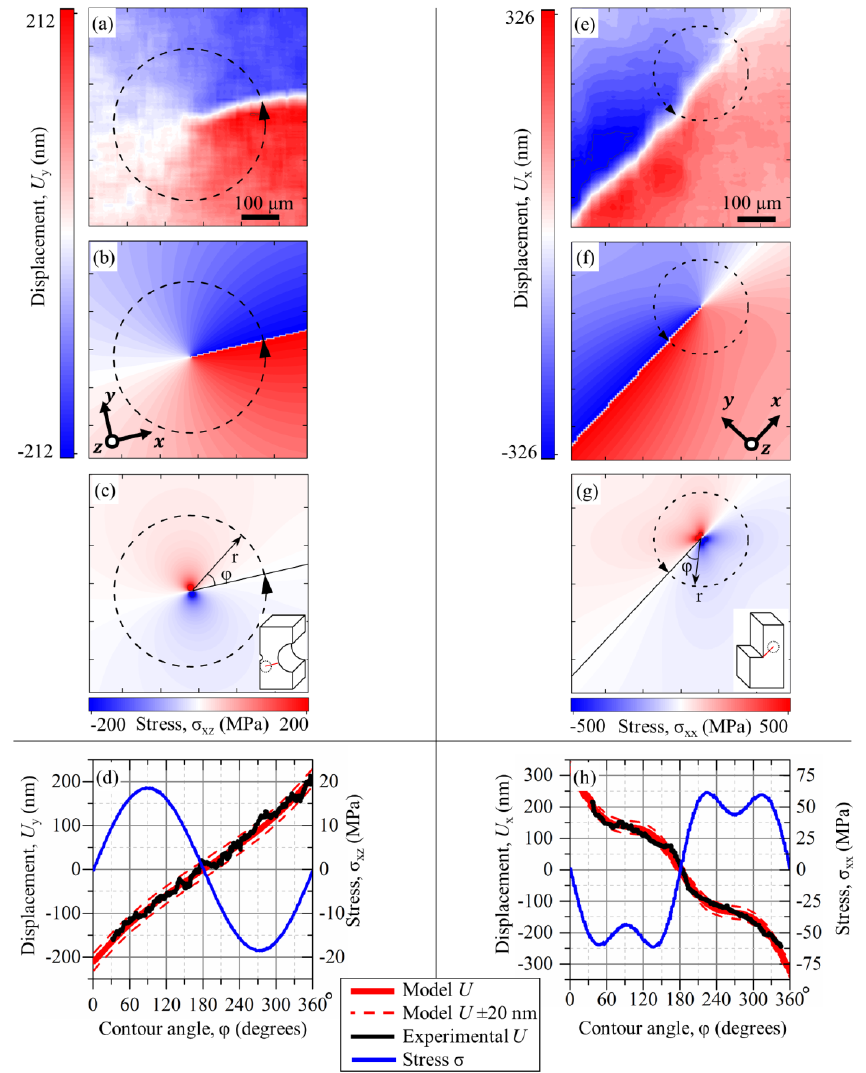
Figure 1. Examples of type III (Left) and type II (Right) shear bands (SBs) in the amorphous Pd40Cu30Ni10P20 deformed in compression. The displacement fields U y ( a , b ) and U x ( e , f ) were measured experimentally ( a , e ) and modelled as Volterra’s screw ( b ) and edge ( f ) dislocations [26]. The σ xz and σ xx components were calculated for the modelled screw ( c ) and edge ( g ) dislocations, respectively. The comparison of experimental (rounds) and model (red lines) displacements as well